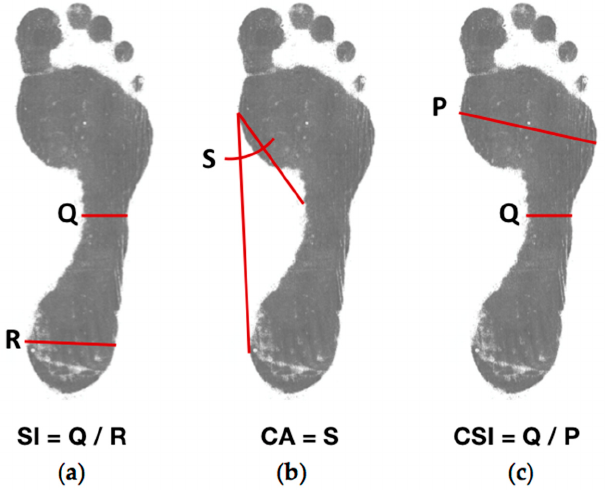
Figure 4. Footprint parameters used by the FPDSS to evaluate the deformities in the footprint: ( a ) Staheli index; ( b ) Clarke’s angle; ( c ) Chippaux-Smirak index. ( a ) Staheli index; ( b ) Clarke’s angle; ( c ) Chippaux-Smirak